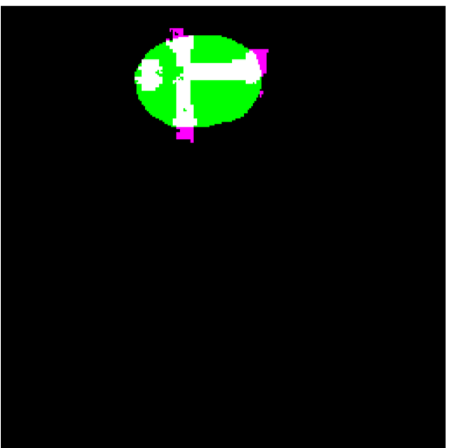
Figure 11. The results of CNN network cancer tumor morphology operations.